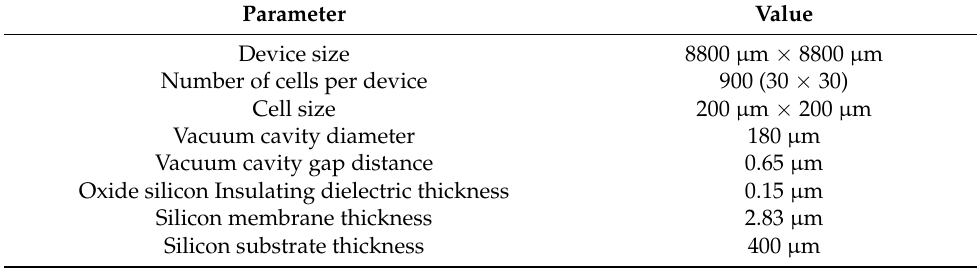
Table 1. CMUT device parameters. Table 1. Capacitive micromachined ultrasound transducer (CMUT) device parameters.